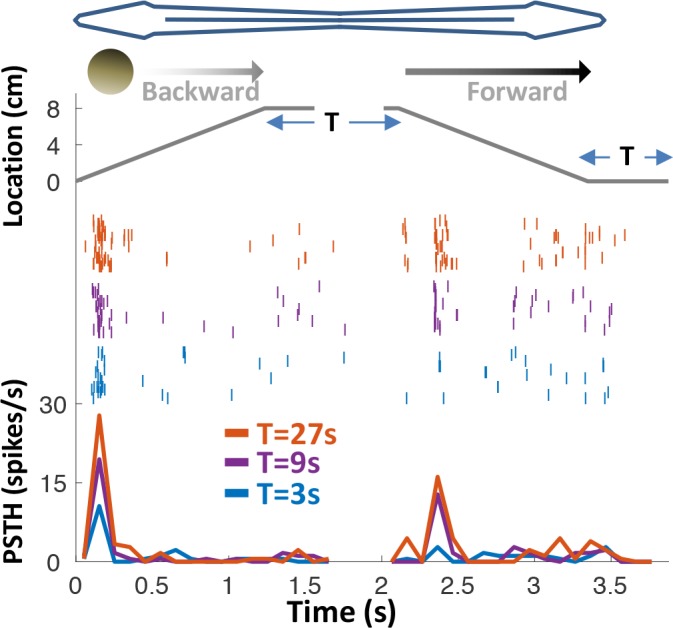
Response adaptation to periodic motion.An example motion-onset responsive cell was stimulated with repetitive back-and-forth longitudinal motion. Duration of wait intervals between movements (T) was 3, 9 or 27 s (color-coded as blue, purple and red, respectively). Top: object position relative to head; middle: spike raster; bottom: PSTHs. 45% (15/33) of PG cells exhibited pronounced adaptation to repeated motion, with time-constants on the order of seconds to tens of seconds. In this example, the response strength for T = 27 s was larger than for T = 9 s, which in turn was larger than for T = 3 s – indicating a time-constant of adaptation >>1 s.